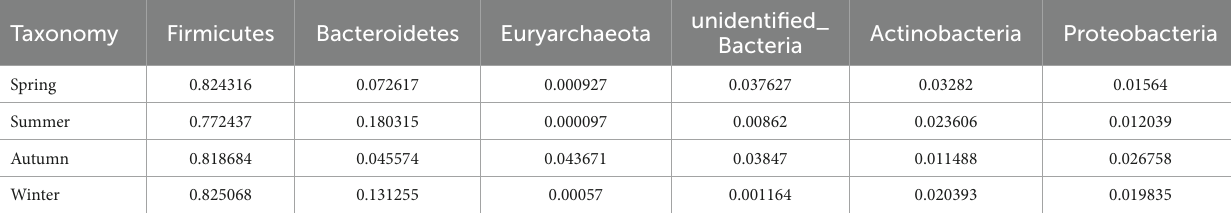
TABLE 2 The abundance of the top 6 species in each season at the phylum level.